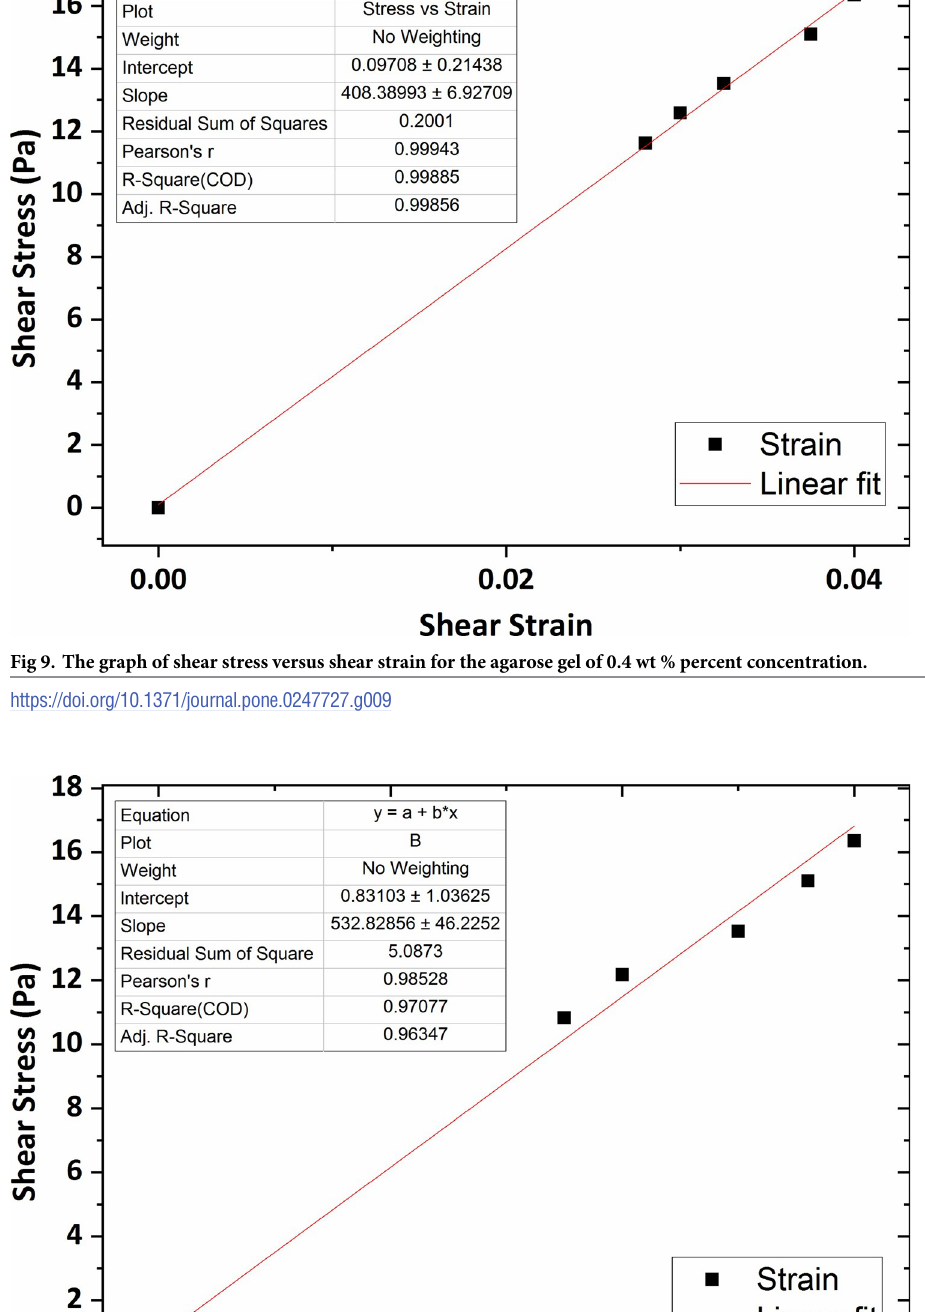
PLOS ONE | https://doi.org/10.1371/journal.pone.0247727 February 25,